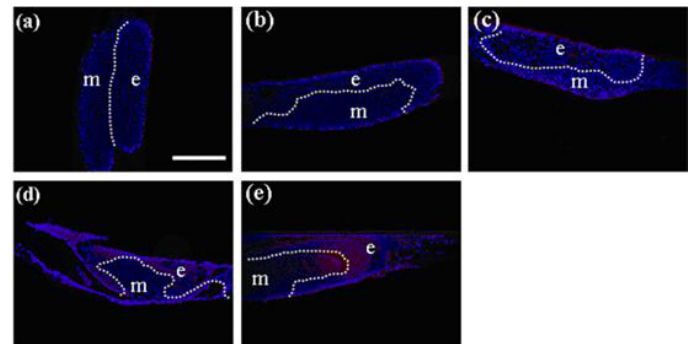
Figure 3. Immunohistochemistry of developing teeth from germs reconstructed with mixed epithelial cells (emtg-2 cells: EC = 1:1) and MT on culture inserts. Germs were cultured for 1 ( a ), 2 ( b ), 3 ( c ), 5 ( d ) and 7 days ( e ). Amelogenin protein (red) became detectable after seven days in culture ( e ). Nuclei were stained with DAPI (blue). E: epithelium, m; mesenchyme, dot line; epithelial- (cid:80)(cid:72)(cid:86)(cid:72)(cid:81)(cid:75)(cid:92)(cid:80)(cid:68)(cid:79)(cid:3)(cid:76)(cid:81)(cid:87)(cid:72)(cid:85)(cid:73)(cid:68)(cid:70)(cid:72)(cid:17)(cid:3)(cid:54)(cid:70)(cid:68)(cid:79)(cid:72)(cid:3)(cid:69)(cid:68)(cid:85)(cid:3)(cid:76)(cid:86)(cid:3)(cid:21)(cid:19)(cid:19)(cid:3)(cid:541)(cid:80)(cid:3)(cid:76)(cid:81)(cid:3)(cid:11) a ) and all figures are at the same magnification.